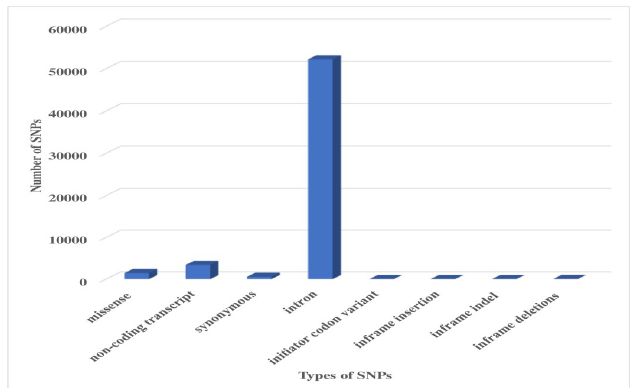
Fig 1. Distribution of SNPs in different functional classes of MTUS1 gene obtained from the dbSNP database.